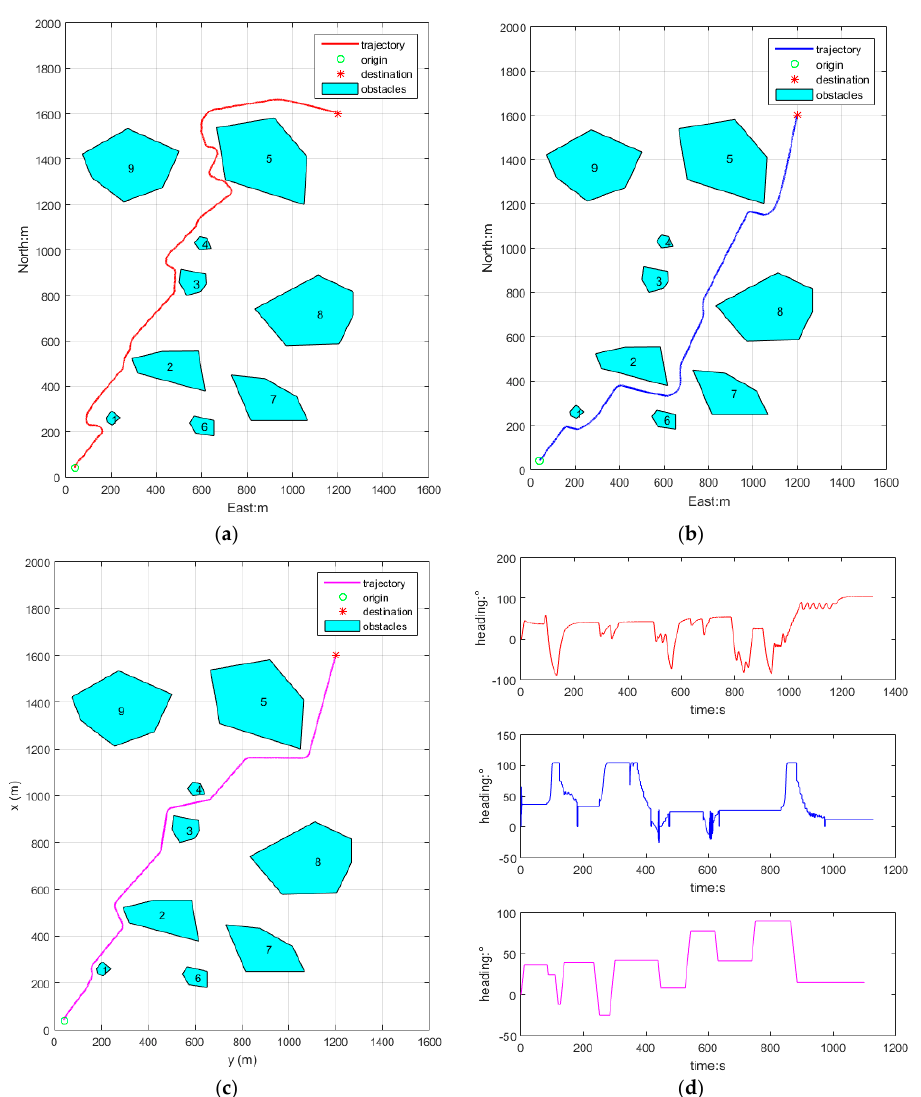
Figure 11. General obstacles environment obstacle avoidance algorithms. ( a ) APF; ( b ) PSO; ( c ) RRA; ( d ) heading curves.